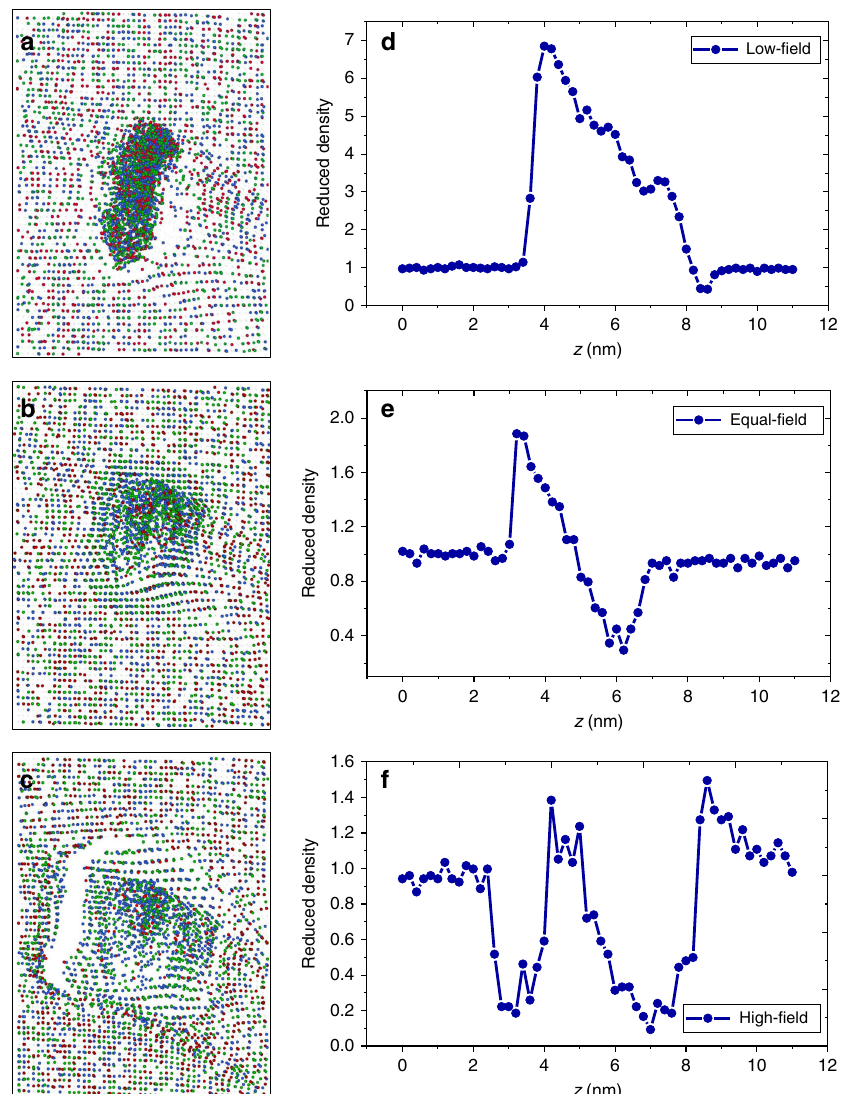
Fig. 3 Atom distributions and 1D local density pro fi les near voids based on fi eld-evaporation simulations. a and d show results with E shell = 0.7 E matrix ; b and e show results with E shell = E matrix ; c and f show results with E shell = 1.3 E matrix . Atom distributions in a , b , c are from 11.2 × 8.3 × 1 nm cuboidal ROIs near the void projected onto the x direction in the simulated APT reconstructions. Each dot represents one atom, with Co, Ni, and Cr atoms shown as blue, green, and red dots, respectively. 1D pro fi les are calculated using a 11 nm long × 3 nm diameter cylindrical ROI through the void center and are oriented parallel to the evaporation direction of the simulated APT